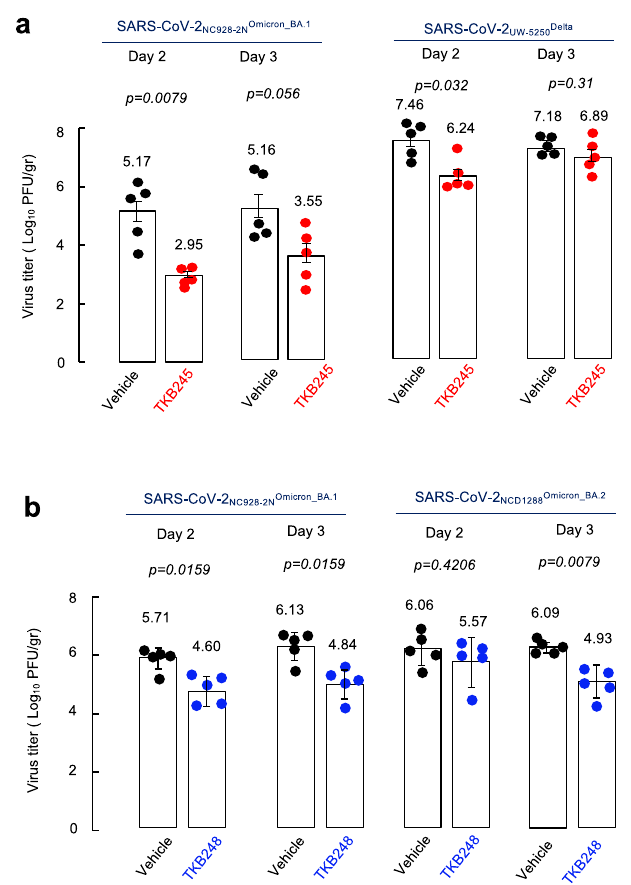
Fig. 2 | In vivo ef fi cacy of TKB245 and TKB248 against SARS-CoV- 2 NC928-2N Omicron_BA.1 , SARS-CoV-2 UW-5250 Delta and SARS-CoV- 2 NCD1288 Omicron_BA.2 -infected hACE2-knocked-in mice. a Five hACE2KI mice per group were challenged intranasally with SARS-CoV-2 NC928-2N Omicron (5×10 5 PFU) or SARS-CoV-2 UW-5250 Delta (5×10 5 PFU).Twohourslater,animalswereintraperitoneally administered 100mg/kg BID TKB245 or vehicle (placebo). Animals were eutha- nizedon2-and3-dayspostinfectionandlungscollectedfordeterminationofvirus titers using VeroE6 TMPRSS2 cells. Bars indicate mean values and error bars represent standard deviations.All p values are calculatedusing the exact Wilcoxon rank-sum test with two-sided, and no multiple adjustment was made. Source data are pro- vided as a Source Data fi le. b Five hACE2K mice per group were challenged intra- nasally with SARS-CoV-2 NC928-2N Omicron_BA.1 (5×10 5 PFU) or SARS-CoV- 2 NCD1288 Omicron_BA.2 (1×10 5 PFU). Two hours later, animals were intraperitoneally administered 120mg/ kg BID TKB248 or vehicle (placebo). Animals were eutha- nizedon2-and3-dayspostinfectionandlungscollectedfordeterminationofvirus titers using VeroE6 TMPRSS2 cells. Bars indicate mean values and error bars represent standard deviations. Allp values are calculated using the exactWilcoxon rank-sum test with two-sided, and no multiple adjustment was made. Source data are pro- vided as a Source Data fi